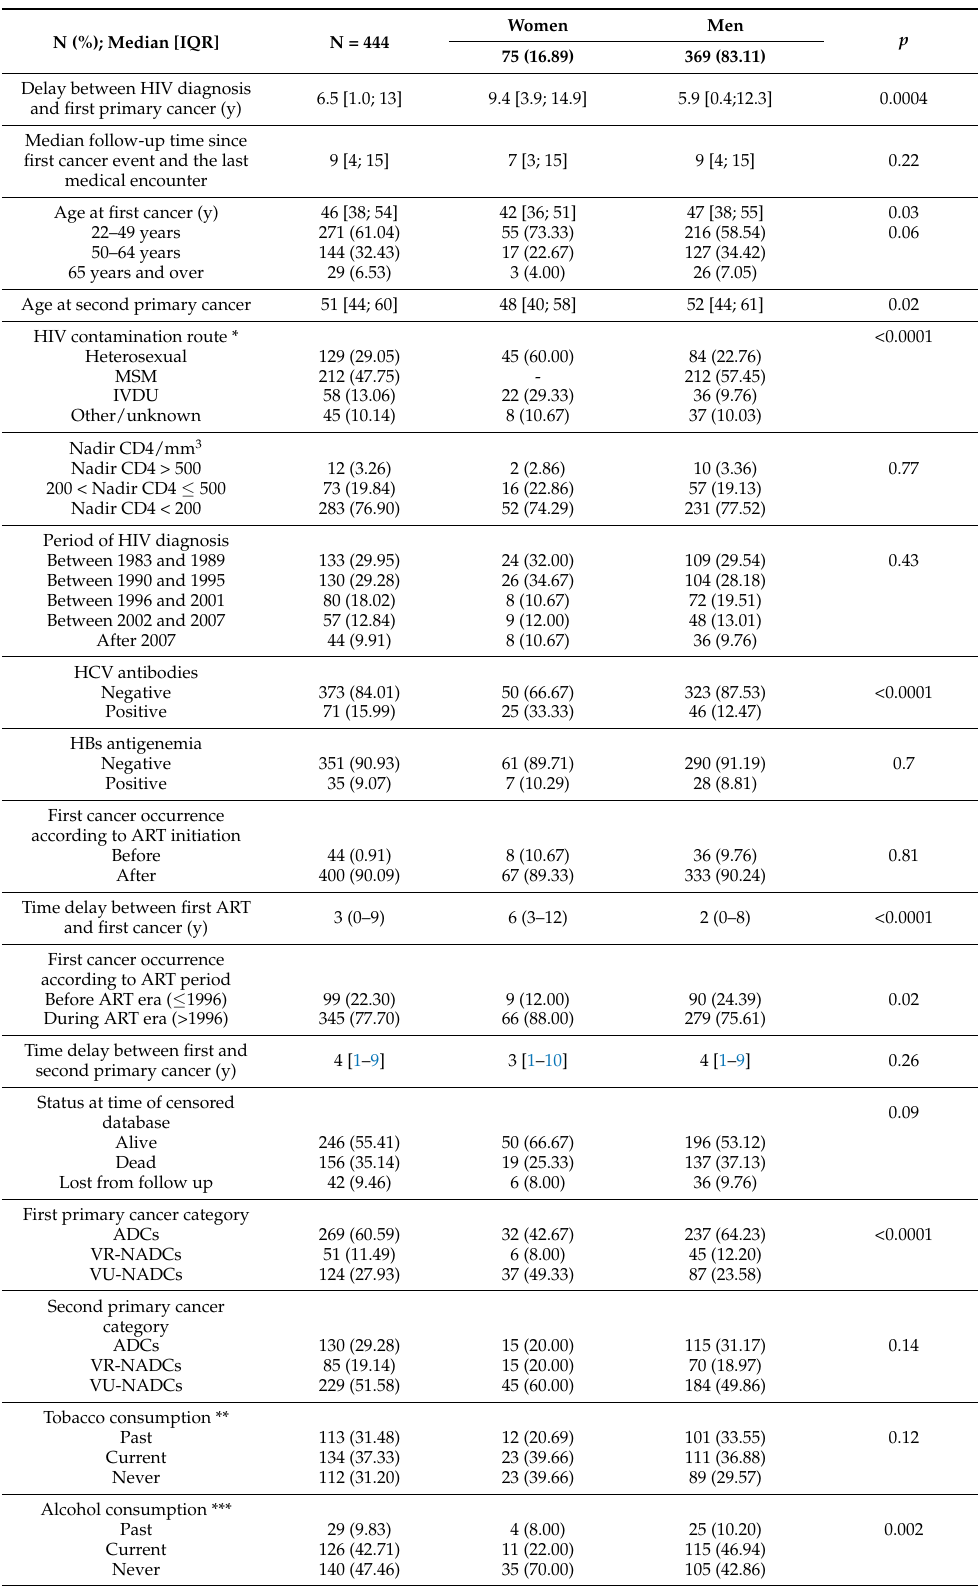
Table 1. Characteristics of patients with a second primary cancer in the French Dat’AIDS